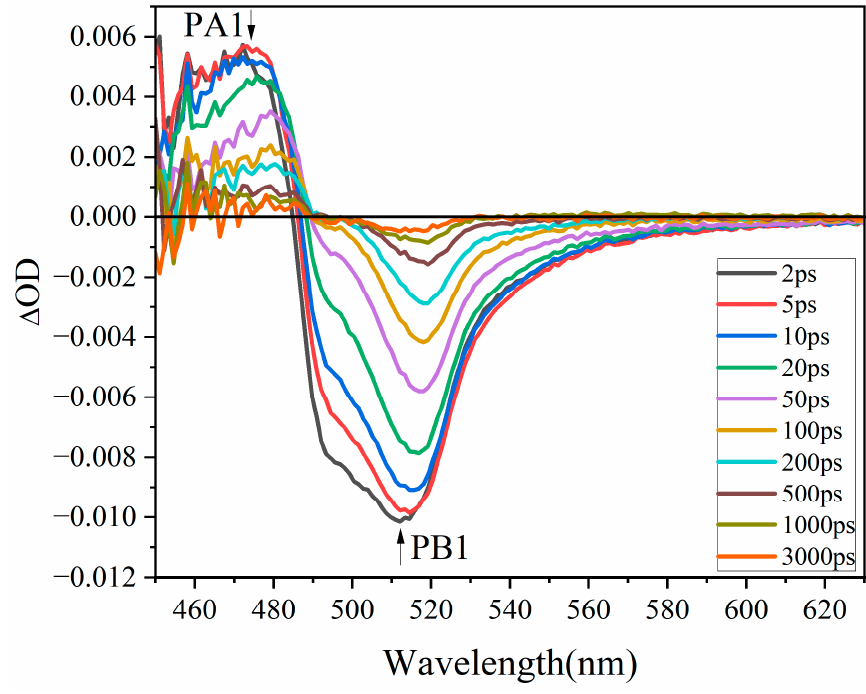
Figure 3. Transient absorption spectra of Mn-doped CsPbBr 3 under atmospheric pressure.